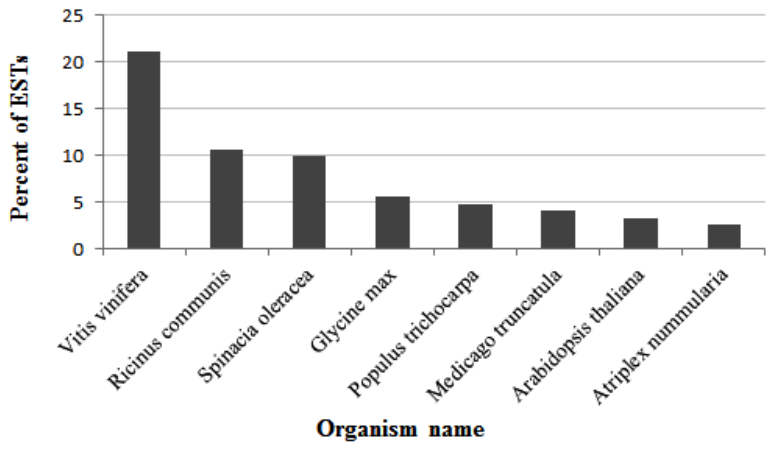
Figure 3. The seven most frequently matched plants according to the BLASTX EST search results. Percentages are with respect to the total set of non-redundant 343